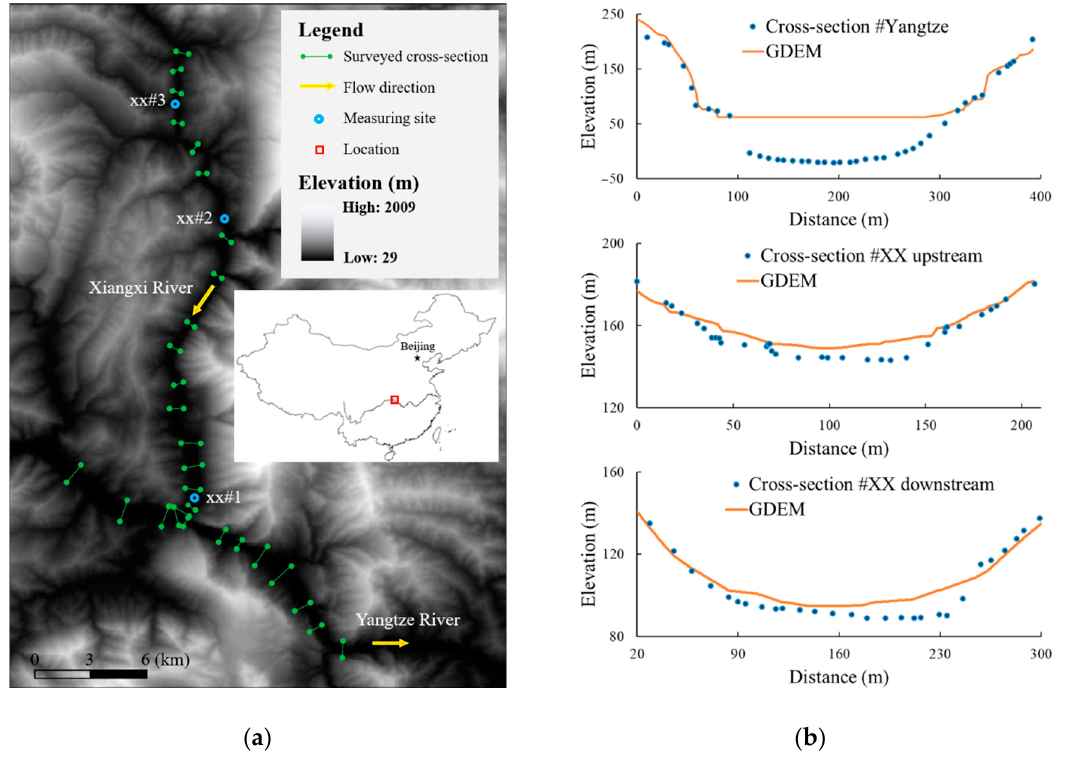
Figure 6. ( a ) Surveyed cross-sections and floodplain DEM used in topography reconstruction of the Three Gorges Reservoir (TGR) area for the 3D computational domain and ( b ) comparison between surveyed data and DEM elevation along three selected cross-sections.